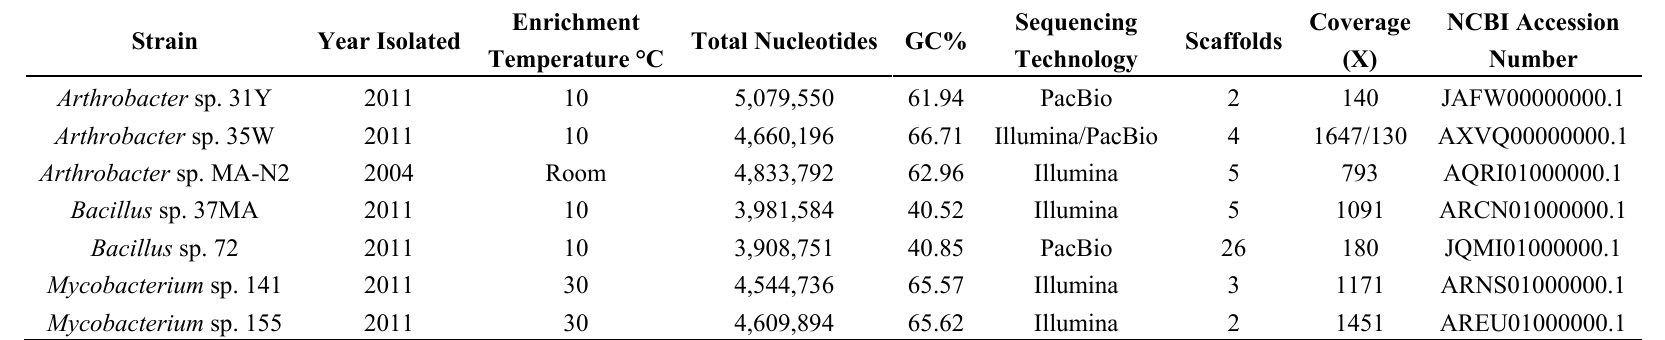
Table 1. Strain isolation details, genome statistics and accession